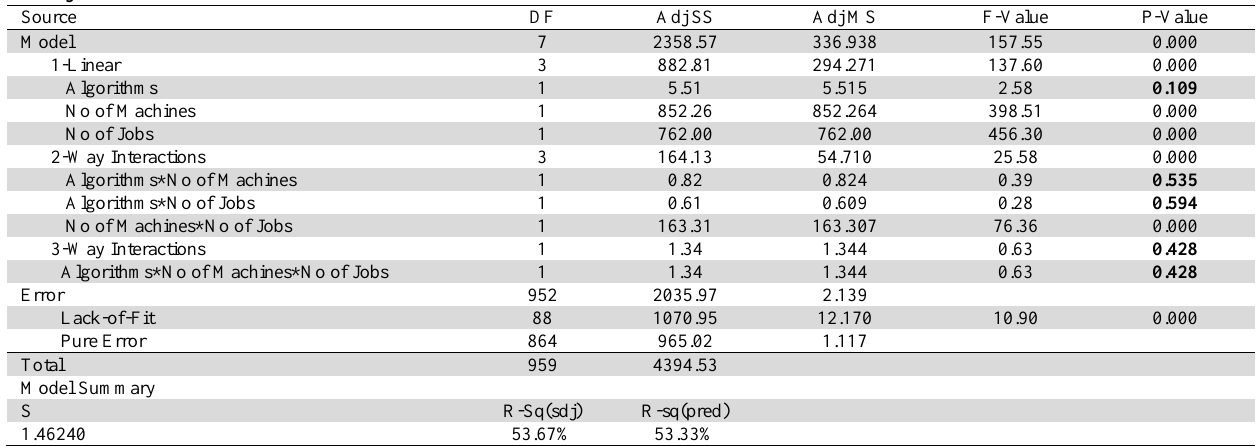
Fig. 7. Normal Plot of the Standardized Effects